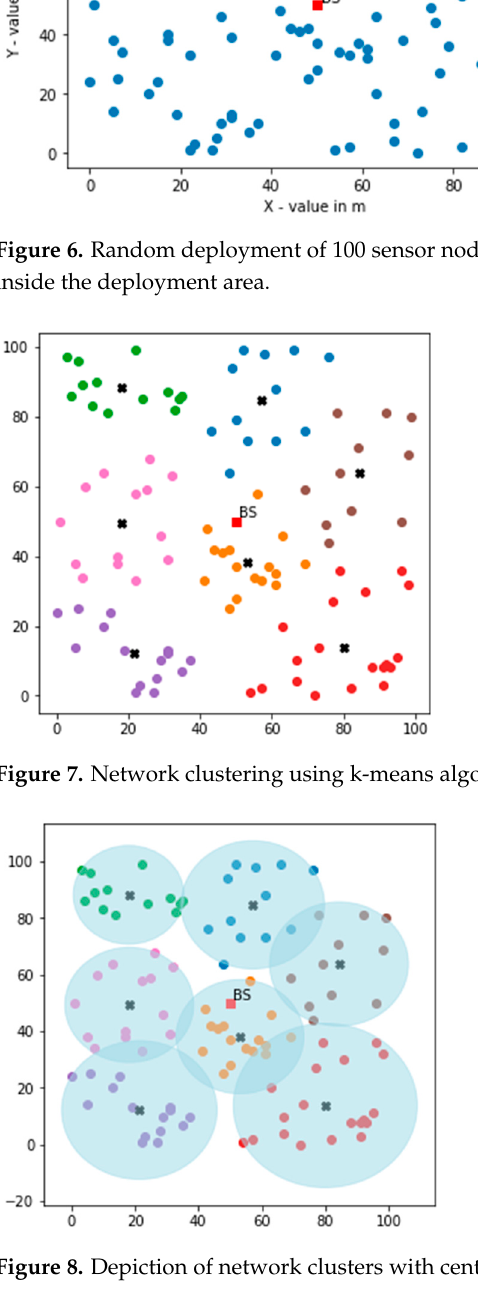
Figure 9. Performance of FEHCA and LEACH in terms of operational nodes per round when base station is positioned inside the deployment area. Table 2. ( a ) Network lifetime comparison of LEACH and FEHCA; ( b ) network lifetime comparison of ESO-LEACH and FEHCA:H_energy_UD. (a) (b) No. of Rounds